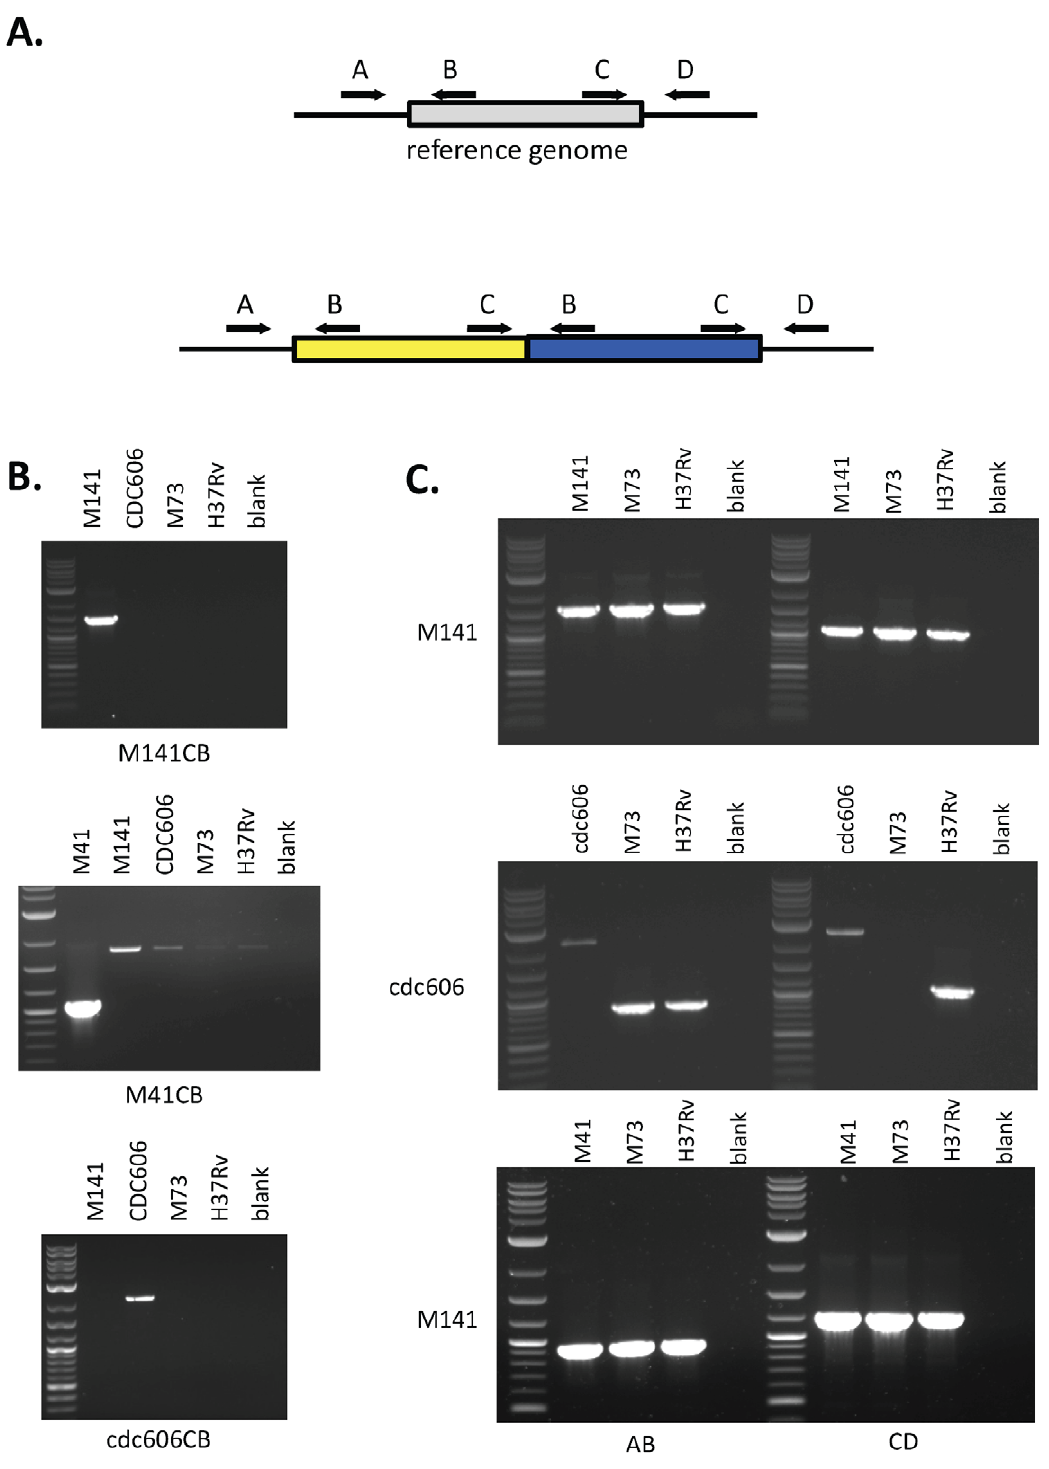
Figure 3. PCR verification of tandem duplications. (A) Schematic representation of primer design strategy. The duplicated region is shown as a grey box, present as a single copy in the reference genome (top) and as a tandem duplication below. Primers A and B amplify the left flank and C and D amplify the right flank. Only when C and B and brought into close proximity by a tandem duplication can a product be generated using primers C and B. (B) 0.9% agarose gel loaded with 5 ul of PCR reactions using primers C and B specific for isolate M141 (top), M41 (middle) and cdc606 (bottom). Lane 1 contains the 2 log ladder (New England Biolabs, N3200). (C) 0.9% agarose gel loaded with 5 ul of PCR reactions using primers A and B (lanes 2– 5) or C and D (lanes 7–10) specific for each isolate as indicated on the left. Lanes 1 and 6 contain the 2 log ladder (New England Biolabs, N3200).